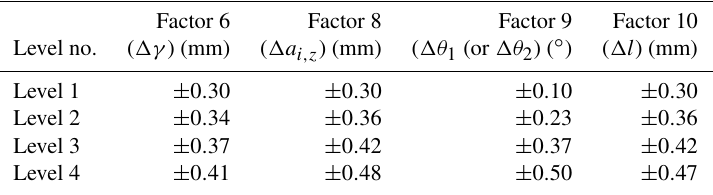
Table 9. Tolerance factor levels re-division for U 20 (4 4 ) array within tolerance zones (part B). Factor 6